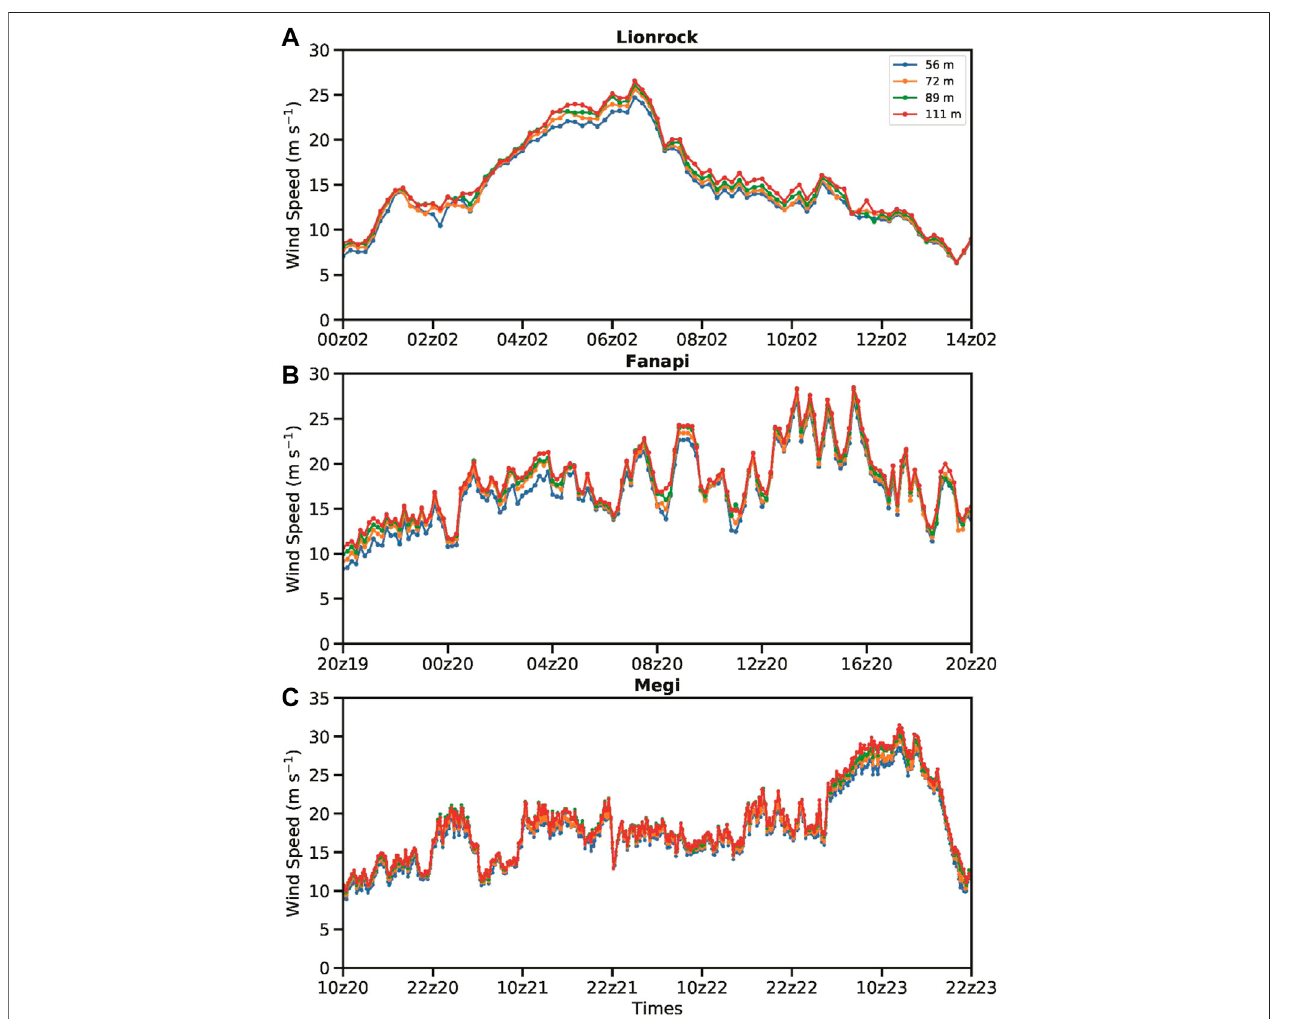
FIGURE2| Time series ofthe10-minaveragesofwind velocity observedwiththetowerinTyphoon (A) Lionrockfrom 11to14UTC2September, (B) Fanapifrom 20 UTC 19 to 20 UTC 20 September, and (C) Megifrom 10 UTC 20 to 22 UTC 23 October 2010. The blue, orange, green, and red curves represent the averaged wind speed at z = 56, 72, 89, and 111 m,